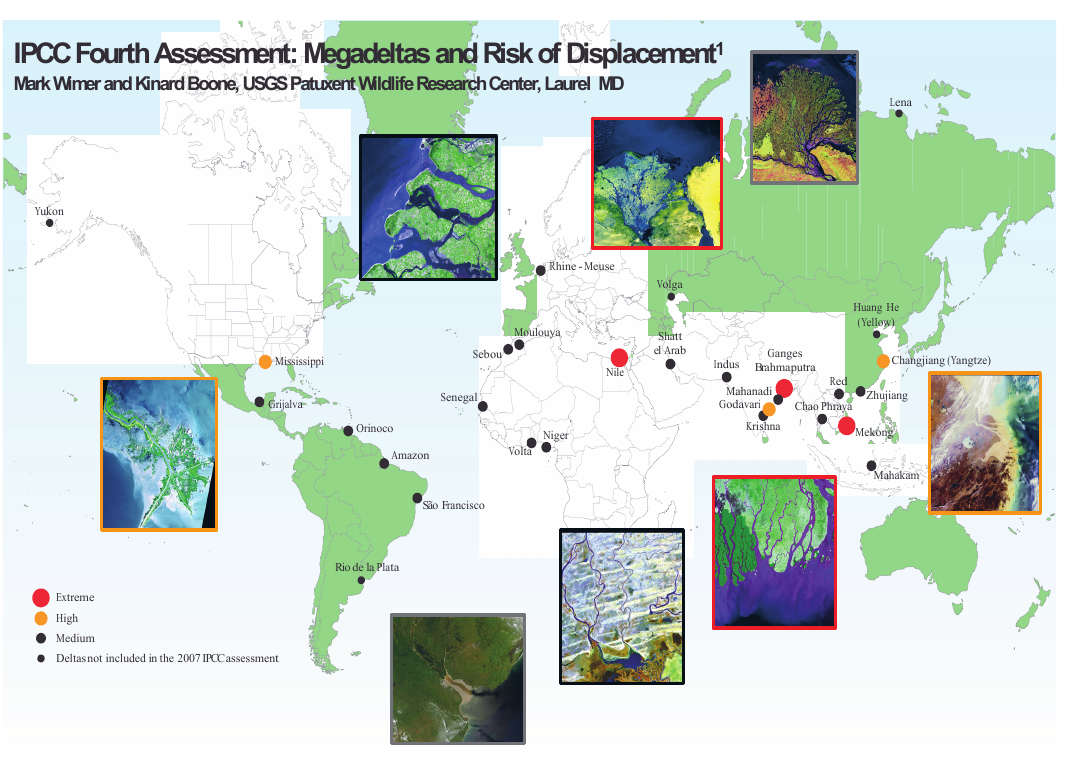
Figure 1. World Mega Deltas threatened by climate and human changes (open source poster modified by USGS from